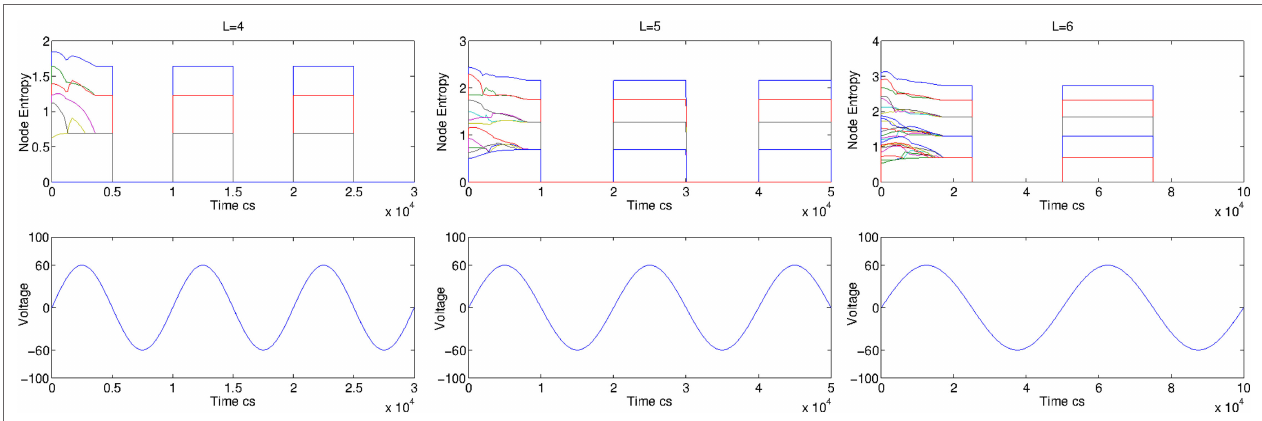
FIGURE 6 | Node entropy based on forward probability for the case of L =4, L =5, and L =6 networks, for a single instance from random initial configuration of the memristors . The frequency has been tuned to let the system thermalize in the upside of the voltage generator. We see that in the negative part of the voltage generator, the entropy becomes zero.